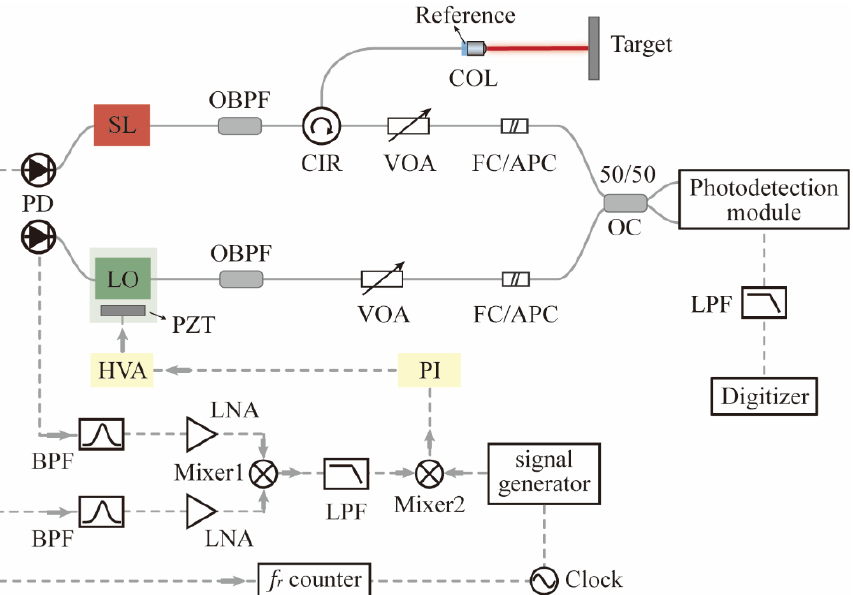
Figure 2. Experimental setup of absolute ranging using linear optical sampling. BPF, radio frequency bandpass filter; FC/APC, ferrule contactor/angled physical contact; HVA, high voltage amplifier; LNA, radio frequency low noise amplifier; LPF, radio frequency low-pass filter; OBPF, optical fiber bandpass filter; PI, proportional-integral controller; VOA, variable optical attenuator.